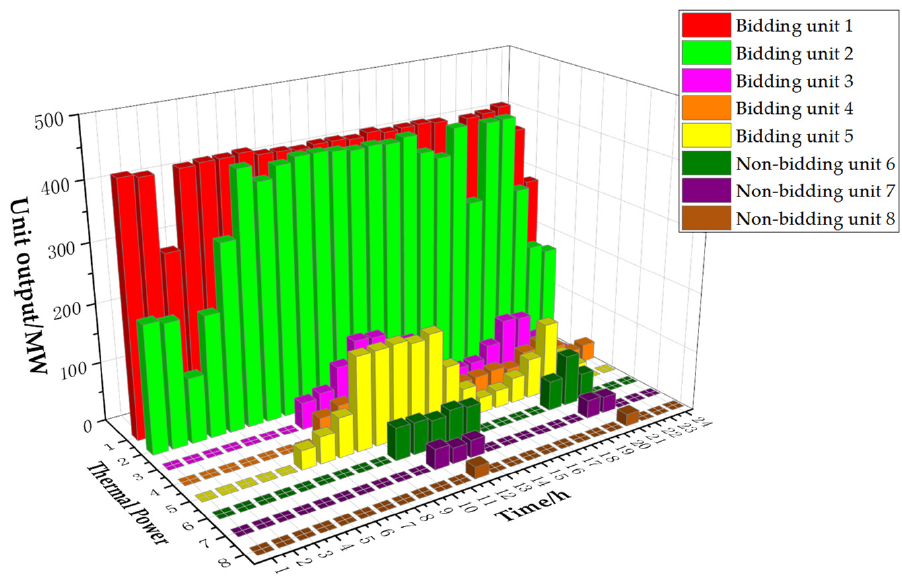
Figure 10. Output of thermal power unit in Case 1.